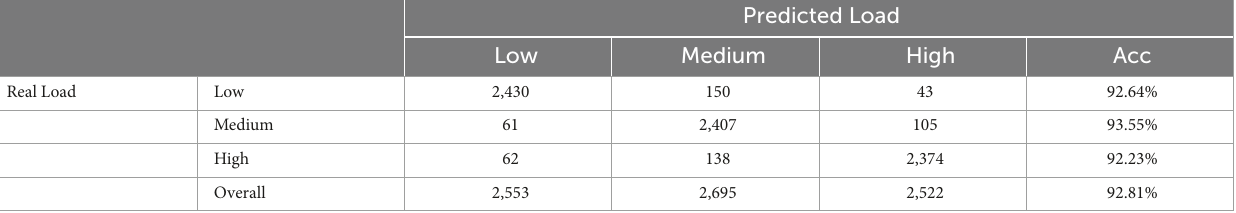
TABLE 4 Results of load classification.